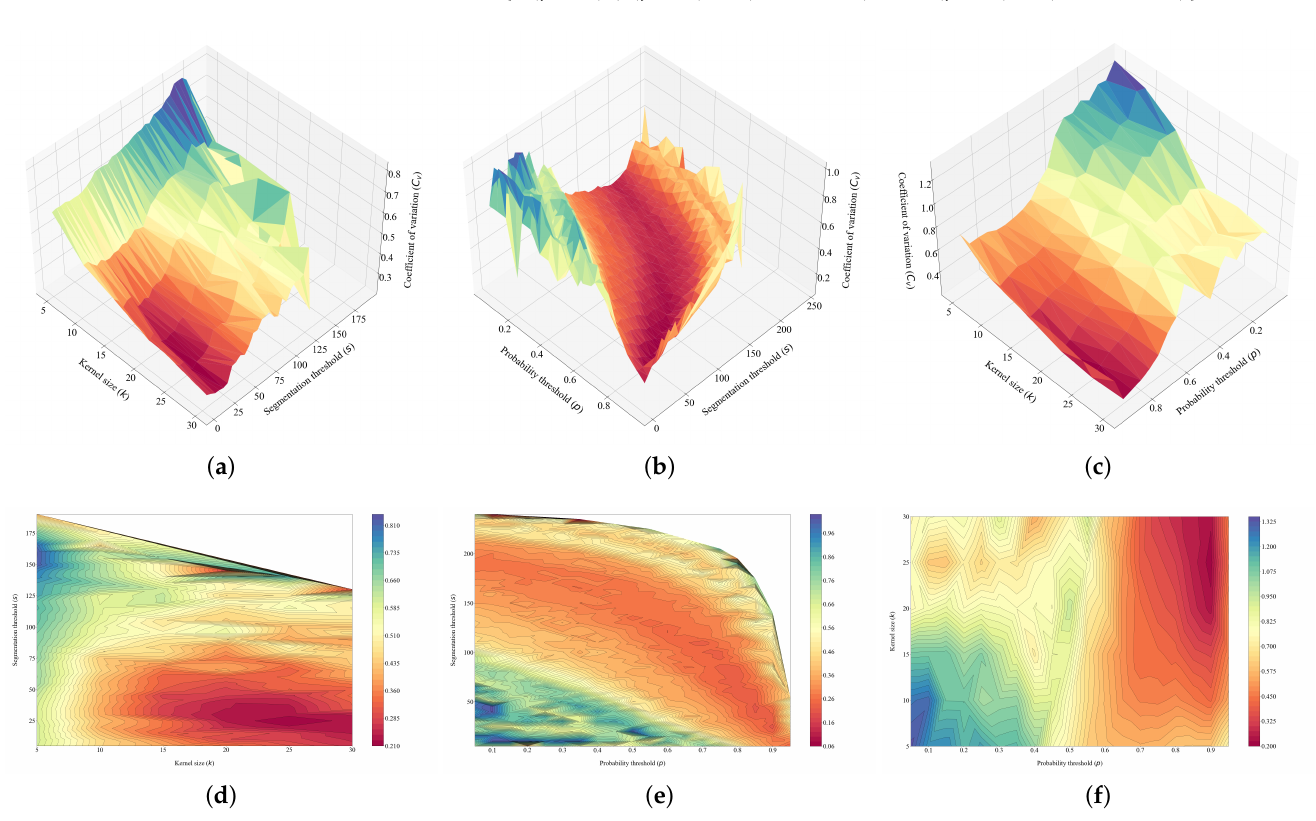
Figure 8. Graphical representation associated with capture 0 in R 3 of the discrete function F , assigning a constant value to one of the parameters in each case. The selected values are the optimum ones computed posteriorly by the model. ( a ) p = 0.9. ( b ) k = 25. ( c ) s = 25. ( d ) p = 0.9. ( e ) k = 25. ( f ) s =